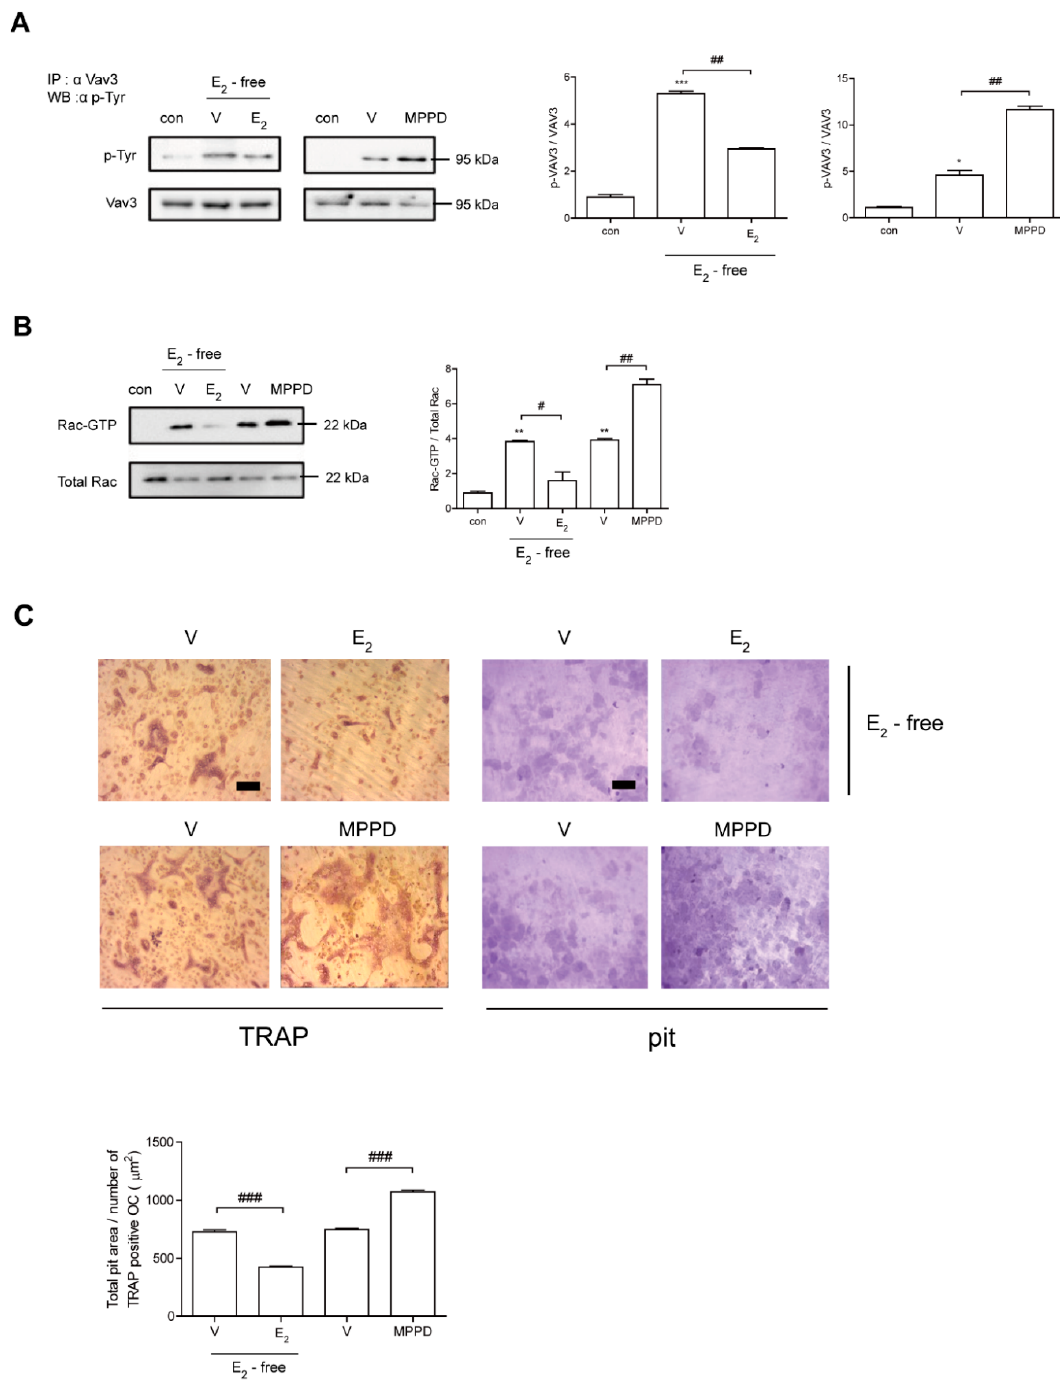
Figure 6. E 2 inhibits RANKL-induced cytoskeletal reorganization via an axis of c-Src/Vav3/Rac1, leading to decreased bone resorption. ( A ) Vav3 was immunoprecipitated from cell lysate, and the phosphotyrosine (p-Tyr) content of the immunoprecipitate was determined by immunoblot with anti-phosphotyrosine Ab. ( B ) GTP-Rac was isolated by GST pull-down and immunoblotted with Rac-specific Ab. ( C ) Mature OCs were incubated further on whole dentine slices with M-CSF and RANKL in the presence or absence of E 2 (5 nM) or MPPD (2 µ M) for 3 days. After TRAP staining, the cells were removed, and the slices were stained with toluidine blue. Representative photos of TRAP-positive OCs and resorption pits are shown. Scale bar in the representative photos: 100 μ m. The total pit area/number of TRAP-positive OCs was calculated. * p < 0.05; ** p < 0.01; *** p < 0.001 compared with control. # p < 0.05; ## p < 0.01; ### p < 0.001 compared with each corresponding control. Similar results were obtained in three independent experiments.